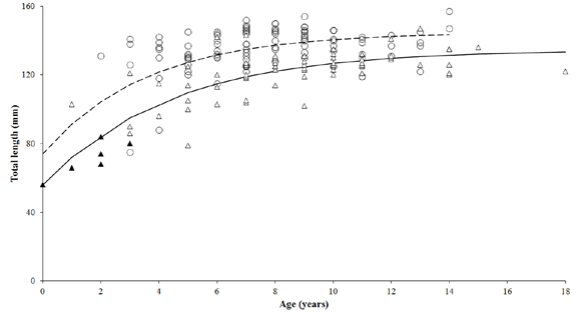
Fig. 4. – Fitted von Bertalanffy growth curves for males (circles, dashed curve) and females (triangles, undashed curve). Black trian- gles denote immature